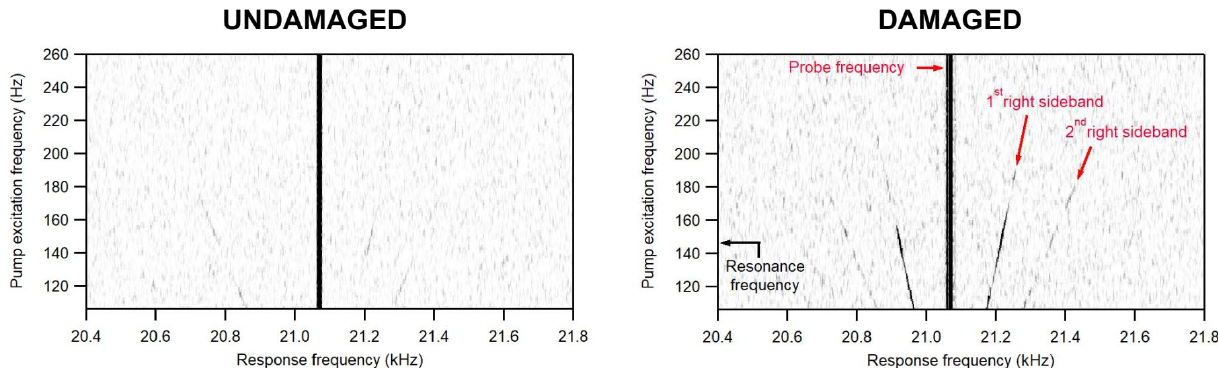
Figure 8. Spectrograms of the response of the beam to a swept pump excitation (frequency range 105–240 Hz) in the undamaged ( left ) and damaged ( right ) conditions.